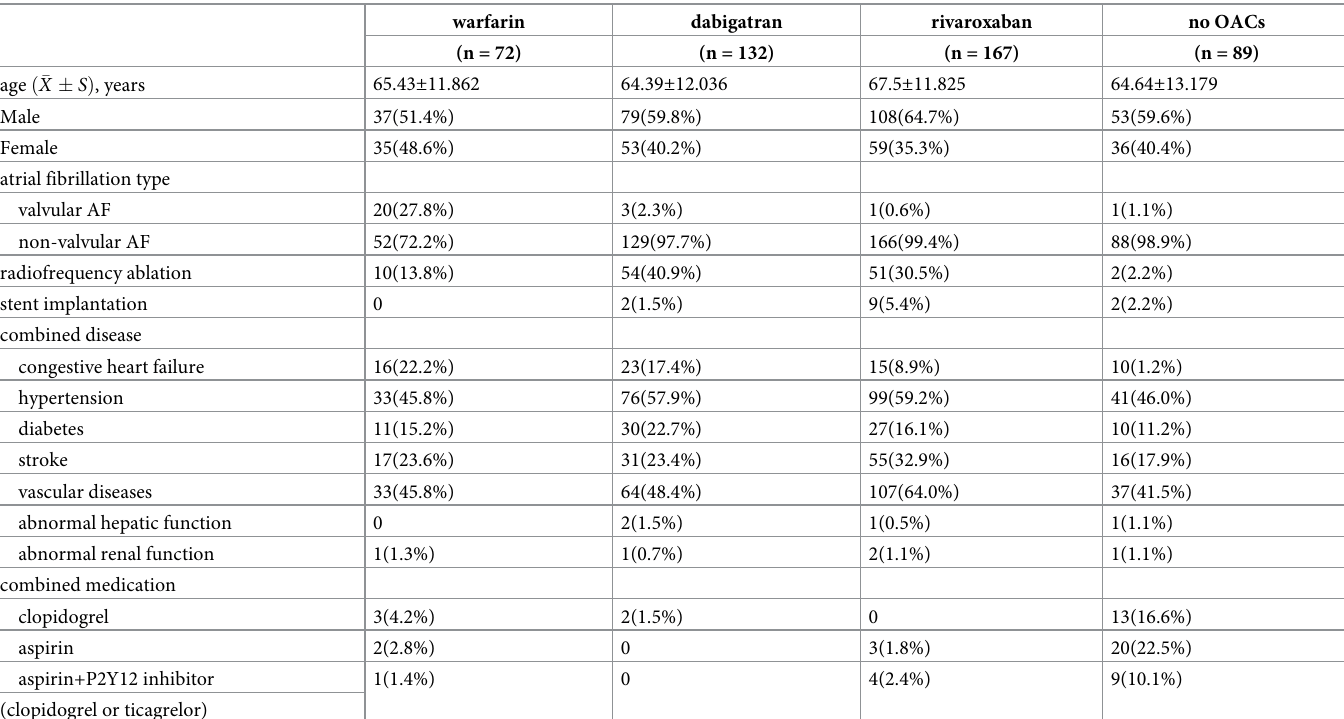
Table 4. Baseline characteristics of the study population.